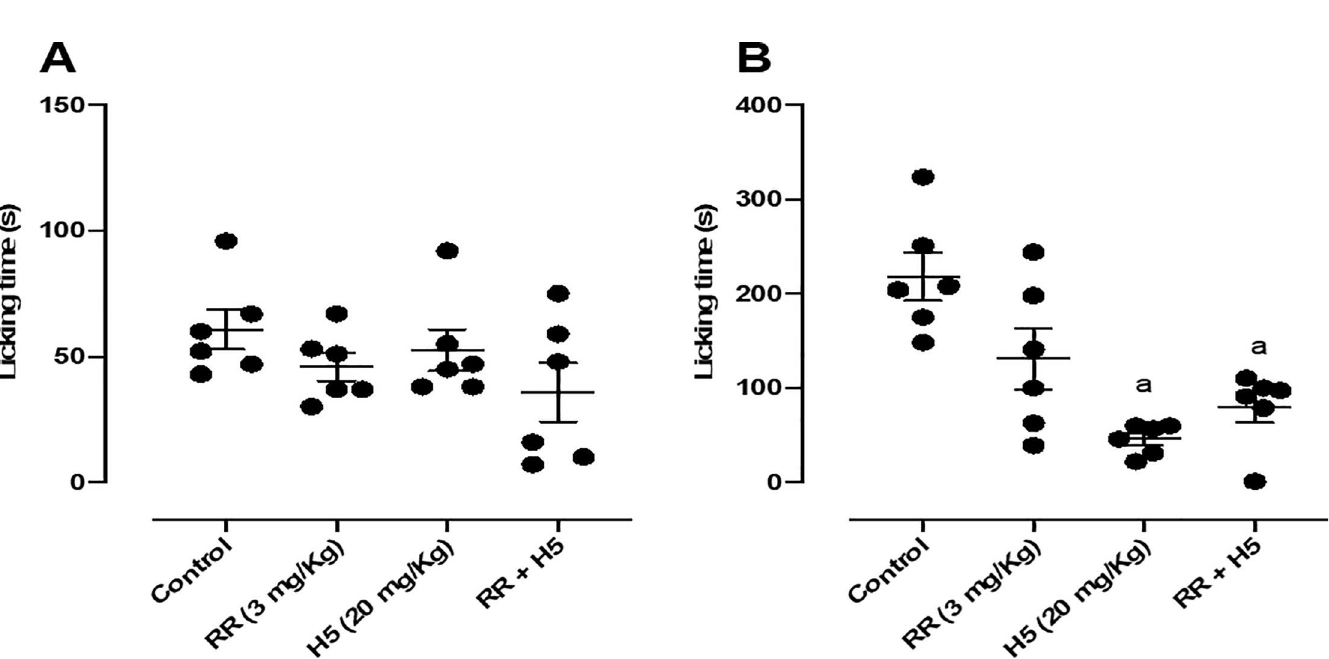
Fig 10. Effect of ruthenium red (3 mg/kg, i.p.), H5 (20 mg/kg, p.o.), ruthenium red + H5 in the first (A) and second (B) phases of the formalin-induced nociception test in mice (n = 6, per group). Values are expressed as the mean ± S.E.M., where a indicates p < 0.05 in comparison with control group, according to ANOVA, followed by Tukey’s